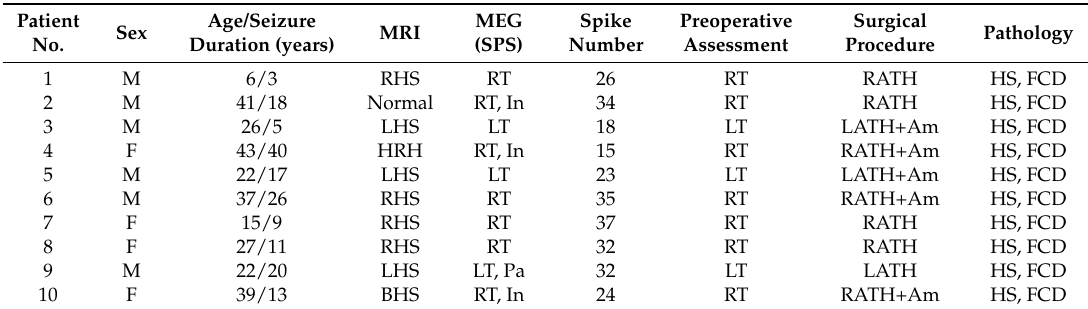
Table 1. Clinical characteristics of the patients.